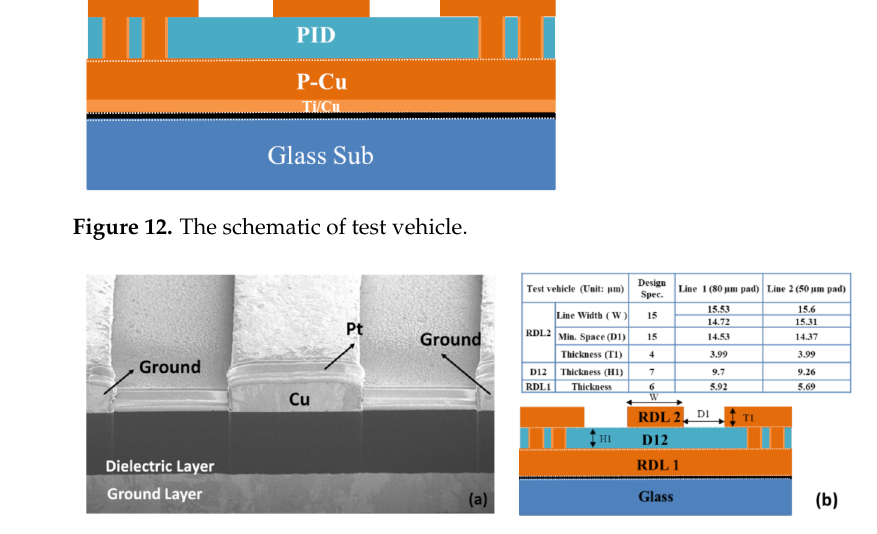
Figure 13. ( a ) The SEM image of test vehicle for TDR measurement and ( b ) detailed dimensions of actual test vehicle.